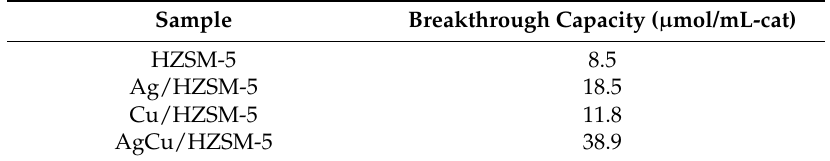
Table 3. Formaldehyde breakthrough capacity of different metal loaded HZSM-5 zeolites